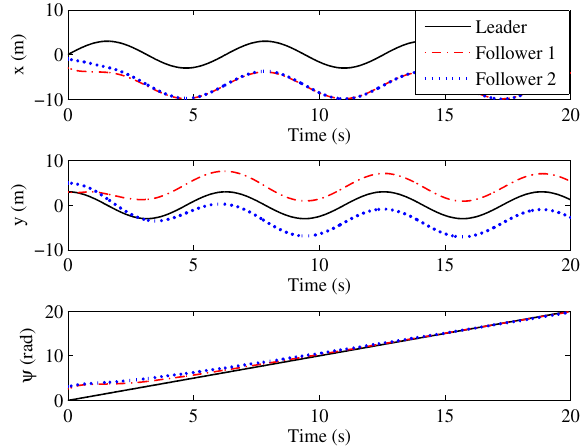
Figure 16. Positions and attitudes of the leader and followers.